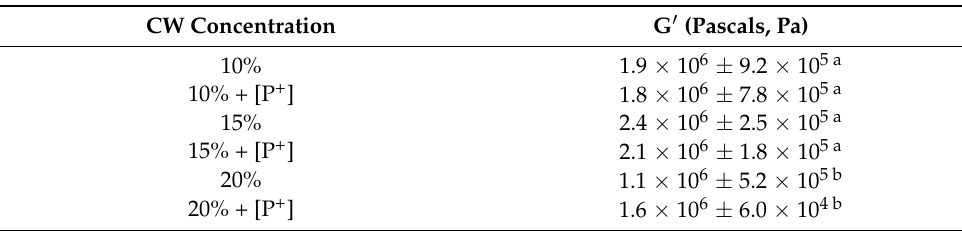
Table 1. Elastic modulus (G’) values of the oleogels with different concentrations of candelilla wax (CW) with and without phosphorus [P + ].